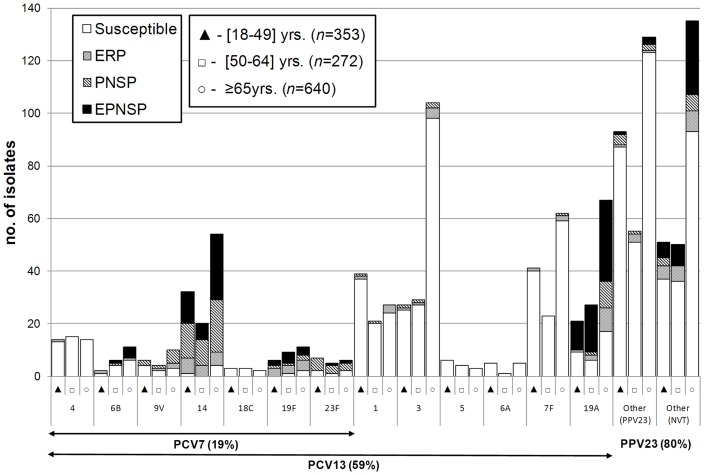
Number of isolates expressing serotypes included in conjugate vaccines causing invasive infections in Portugal (2009–2011).The number of isolates expressing each serotype in each of the age groups considered is indicated. Isolates recovered from patients 18 to 49≥65 yrs are indicated by open circles. Isolates presenting both erythromycin resistance and penicillin non-susceptibility (EPNSP) are represented by closed black bars. Penicillin non-susceptible isolates (PNSP) are indicated by dark hatched bars. Erythromycin resistant pneumococci(ERP) are indicated by light hatched bars. Isolates susceptible to both penicillin and erythromycin are represented by white open bars. The serotypes included in each of the conjugate vaccines are indicated by the arrows. NVT – non-vaccine serotypes, i.e., serotypes not included in any of the currently available vaccines (PCV13 and PPV23). Twenty-eight NVT were detected representing 236 isolates as follows: 6C (n = 36); 23A (n = 20); 12B (n = 19); 16F (n = 18); 23B and 33A (n = 16 each); 15A and 29 (n = 15 each); 24F (n = 13); non-typable (n = 10); 31, 34 and 35F (n = 8 each); 7C, 25A and 35B (n = 5 each); 21 (n = 4); 18A (n = 3); 13 and 17A (n = 2 each); 7A, 11C, 15F, 24A, 25F, 28A, 28F and 37 (n = 1 each).